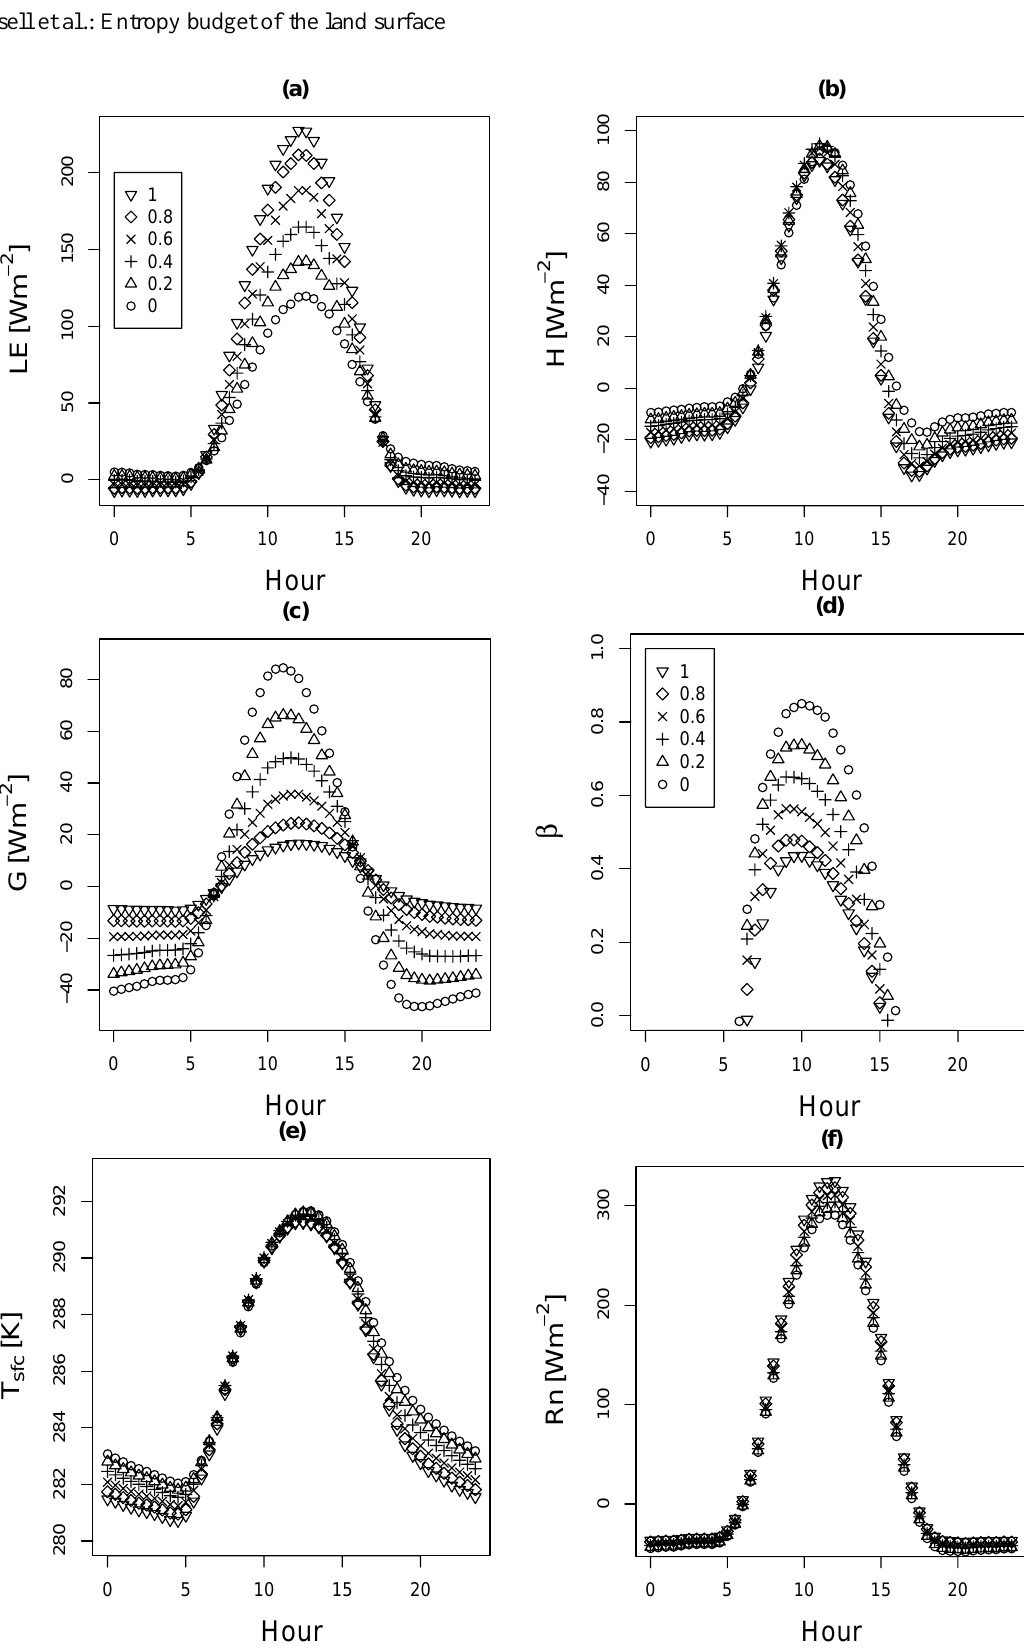
Fig. 5. Mean diurnal variability of (a) latent heat flux (b) sensible heat flux (c) soil heat flux (d) Bowen ratio ( β = H /LE) (e) surface temperature and (f) net radiation as a function of vegetation fractional